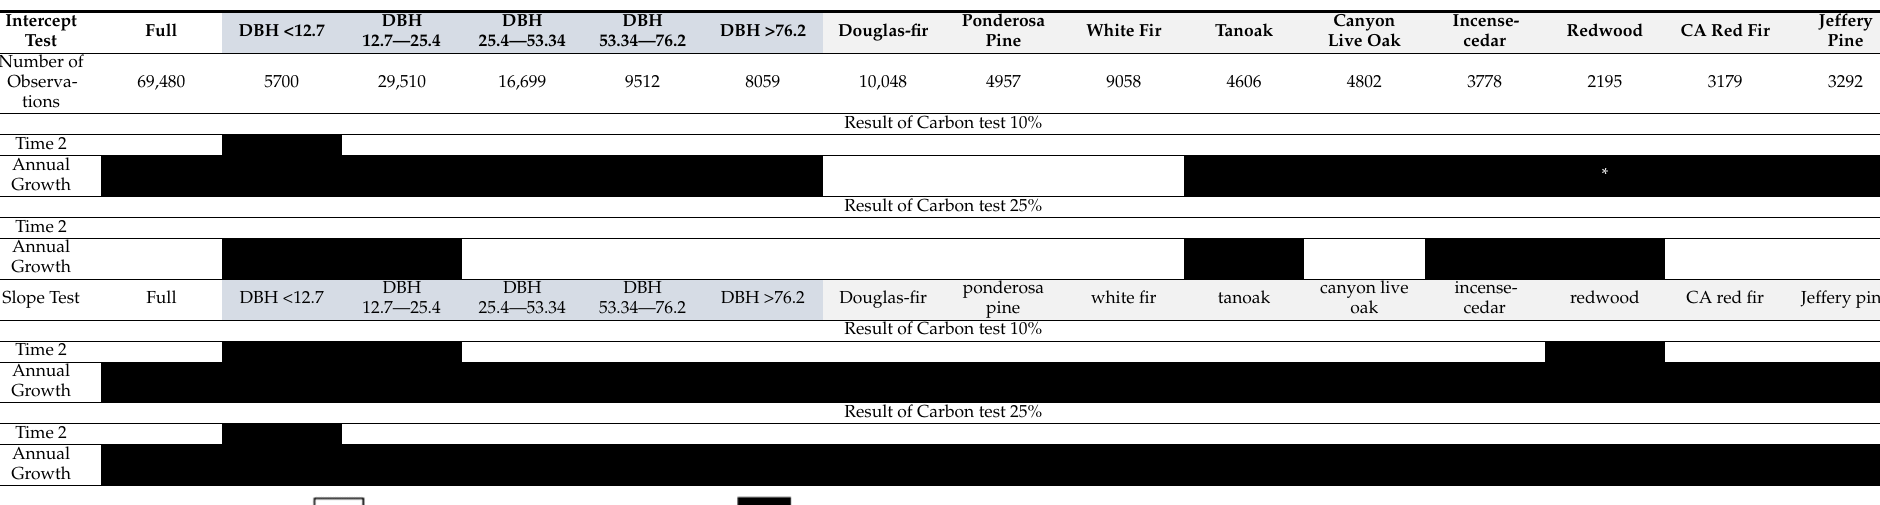
Table 4. Tree-level equivalence test results for above-ground, non-foliar, tree carbon stocks predicted ~10 years forward and annual carbon growth for subsets of diameter groups and species. Blackened boxes indicate tests that failed to reject the null hypothesis of dissimilarity. The black box with the white asterisk indicates the test where the bootstrapped sample is above the equivalence region.